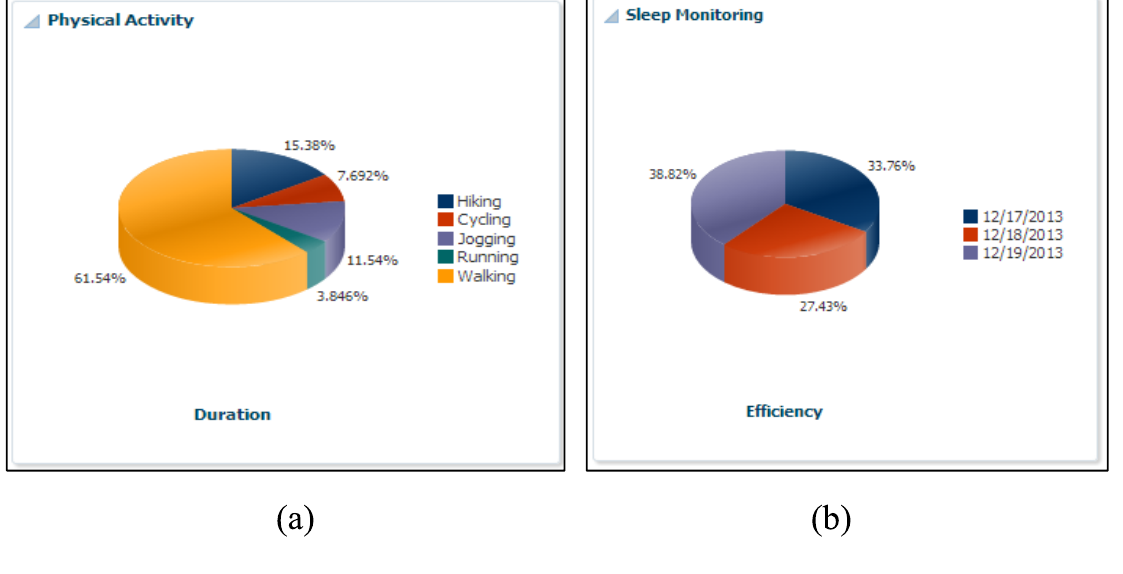
Figure 3. Health primitive calorie